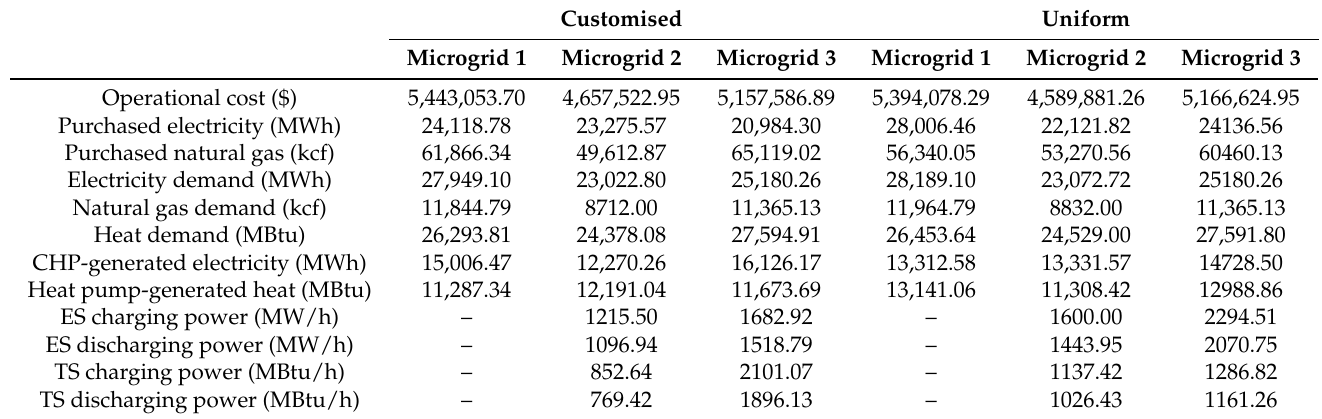
Table 6. Microgrids energy management results under customised and uniform pricing schemes. – : Not